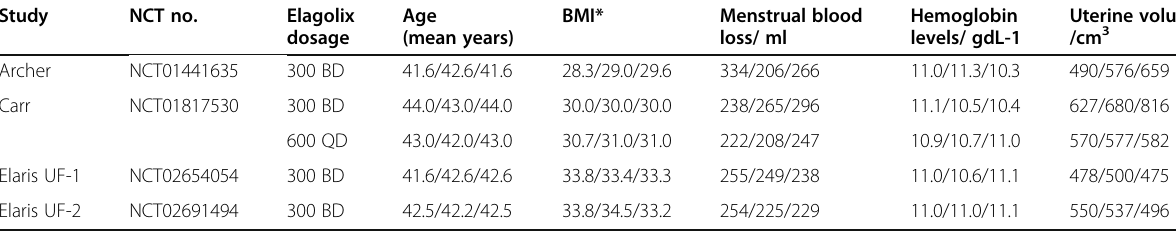
Table 3 Study demographics and baseline clinical characteristics